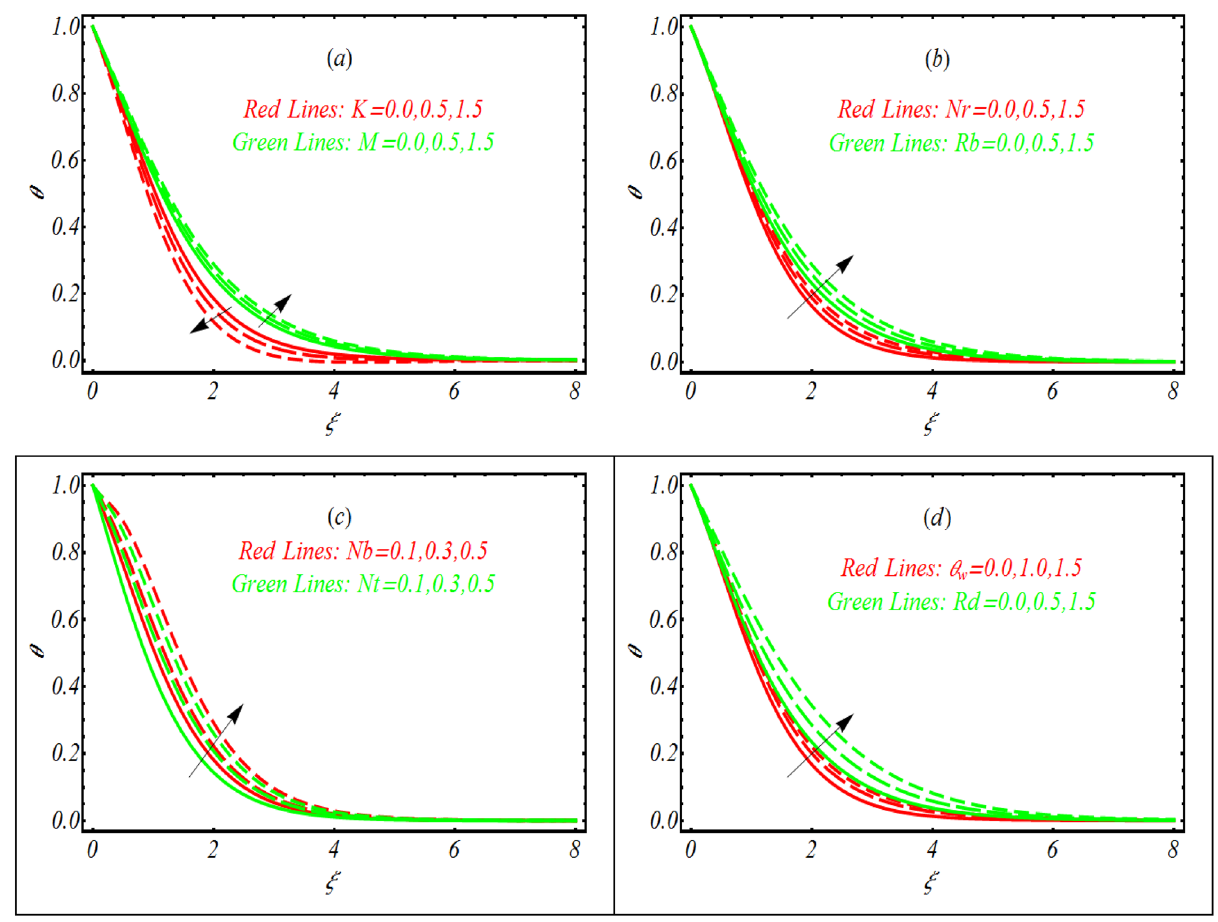
Figure 4. Variation of θ for various values of ( a ) K and M ( b ) Nr and Rb ( c ) Nt and Nb . ( d ) Rd and θ w